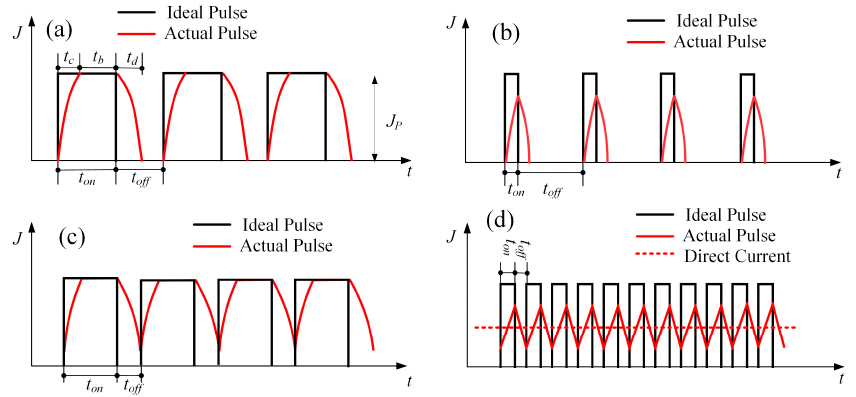
Figure 9. Schematic diagram of pulse waveform in ideal and actual conditions: ( a ) the distortion of the pulse waveform; ( b ) waveform with extremely small duty cycle; ( c ) waveform with extremely large duty cycle; ( d ) waveform with extremely large frequency.